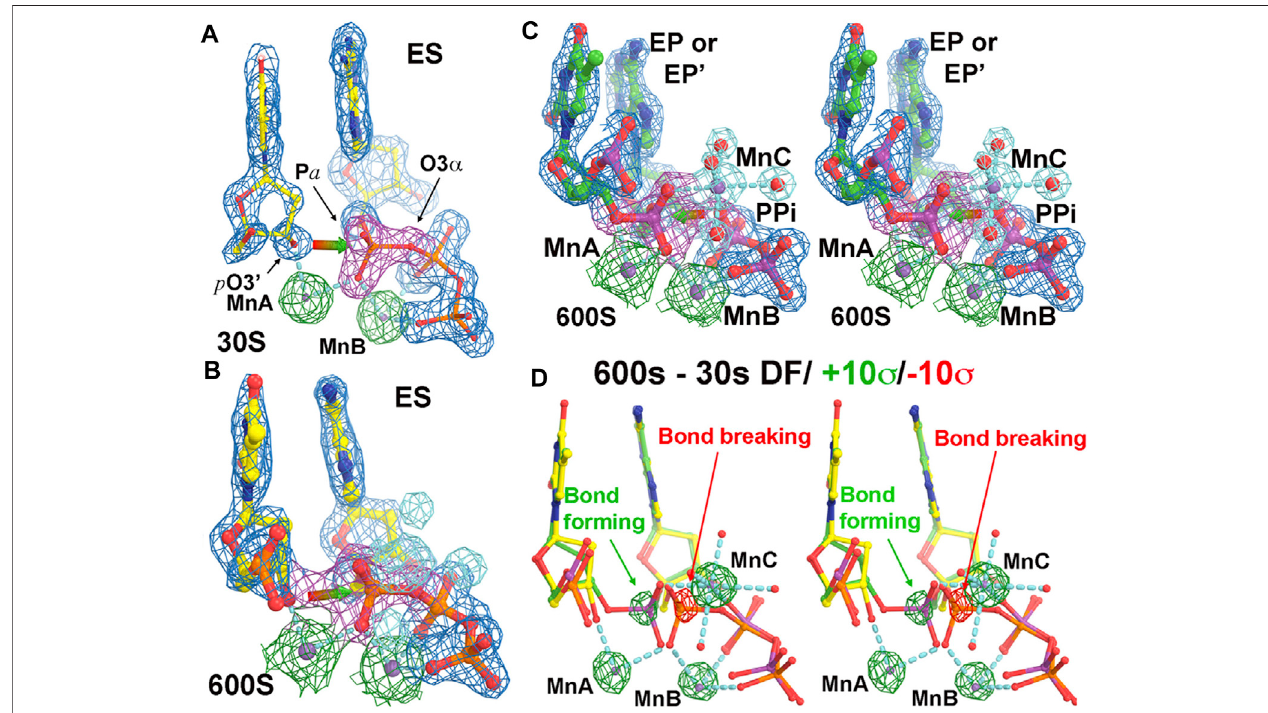
FIGURE 2 | Time-dependent human polymerase η structures (adapted from Wang and Smithline, 2019). (A) At 30 s time point. The σ densitymapcontouredat2 σ (blueforoverallstructure,greenfortwometalionsAandB,andmagentaforthephosphategroup). (B) At600 s.NewfeaturesforMnCand its ligand water molecules (cyan) gradually appear with time. (C) Stereodiagram ofthe 600 s structure. (D) Stereodiagram of differenceFourier maps between the 600 s and 30 s structures contoured at +10 σ (green) and − 10 σ